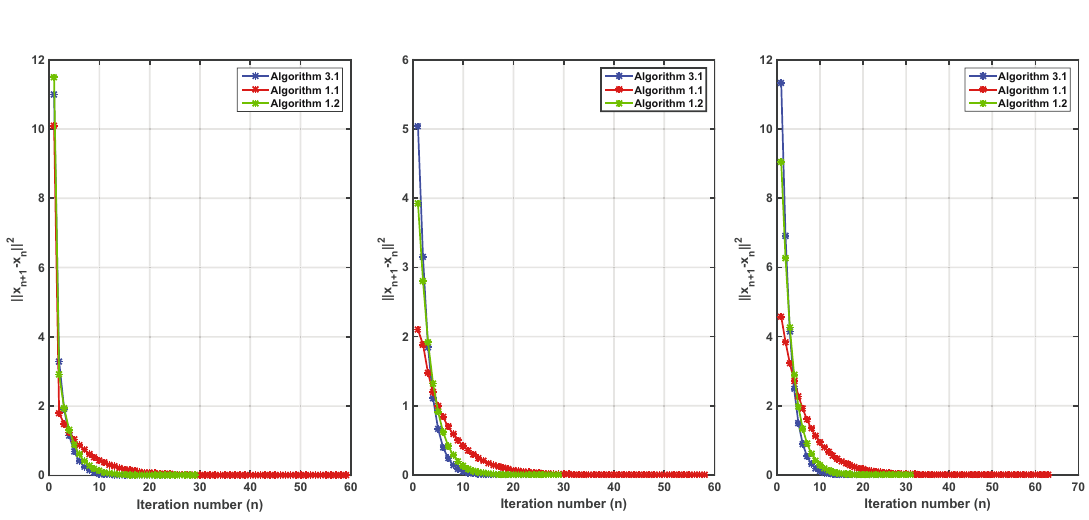
Algorithm 3.1 Algorithm 1.1 Algorithm 1.2